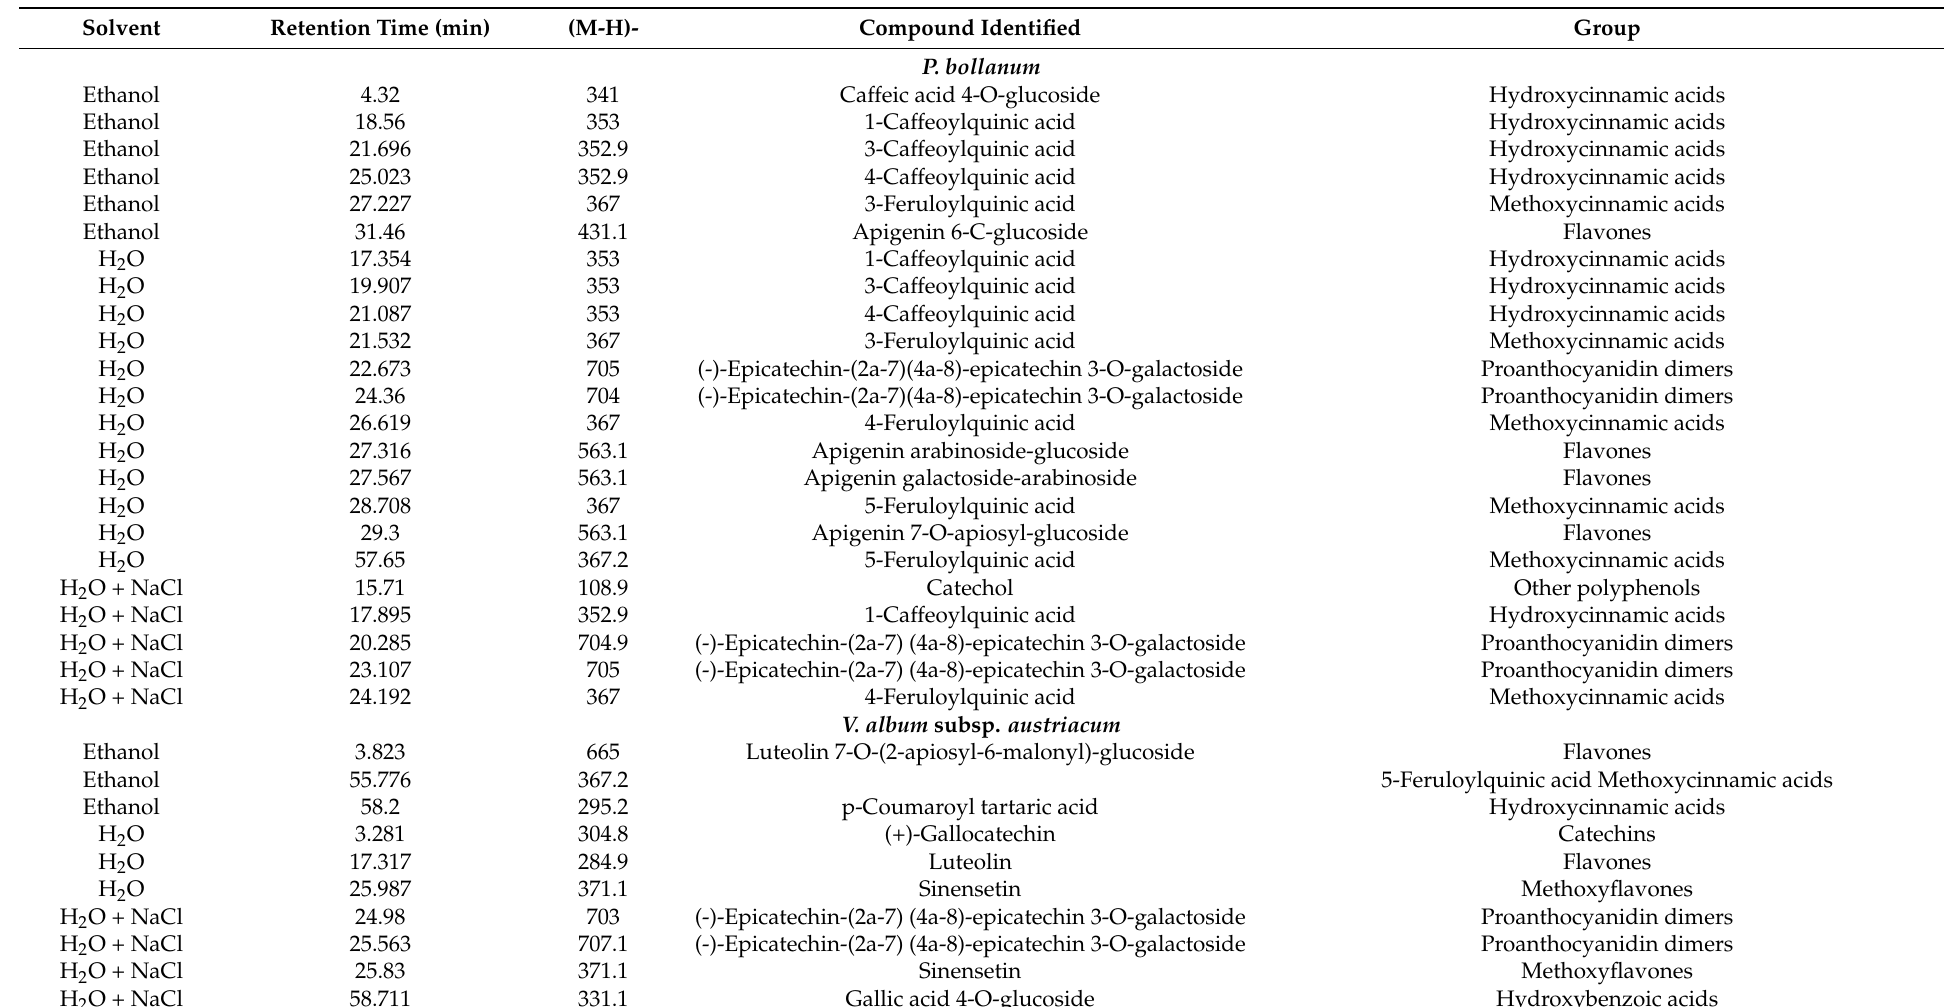
Table 4. Results of HPLC-MS analysis to identify compounds present in extracts of P. bollanum and V. album subsp. austriacum obtained with ethanol, water, and liquid salt